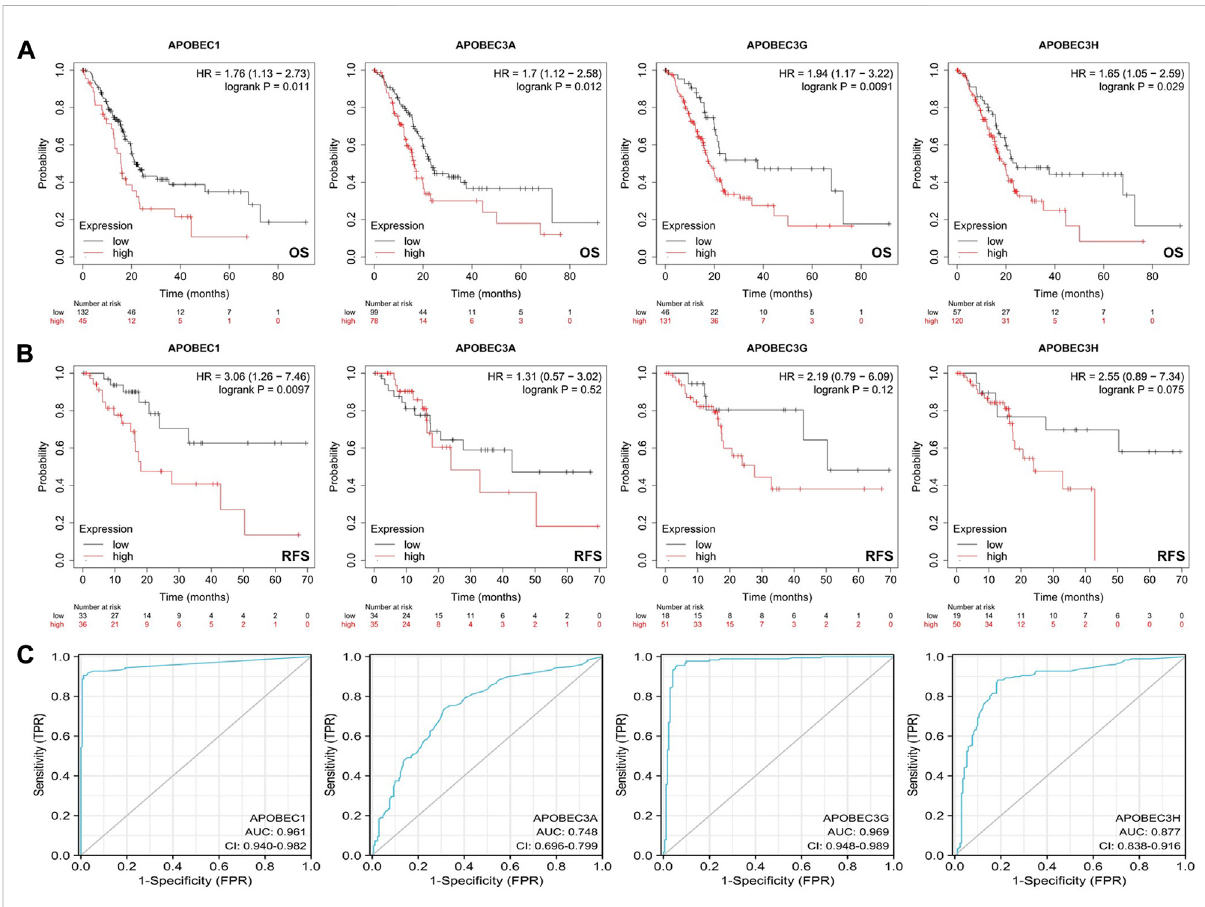
FIGURE 2 Survival analysis of the APOBEC family members APOBEC1, APOBEC3A, APOBEC3G and APOBEC3H in PAAD. (A) The increased expression levels of APOBEC1/3A/3G/3H were signi fi cantly correlated with shorter OS; (B) The increased expression level of APOBEC1 was signi fi cantly correlated with shorter RFS; (C) APOBEC1/3A/3G/3H showed high accuracy in predicting normal and neoplastic